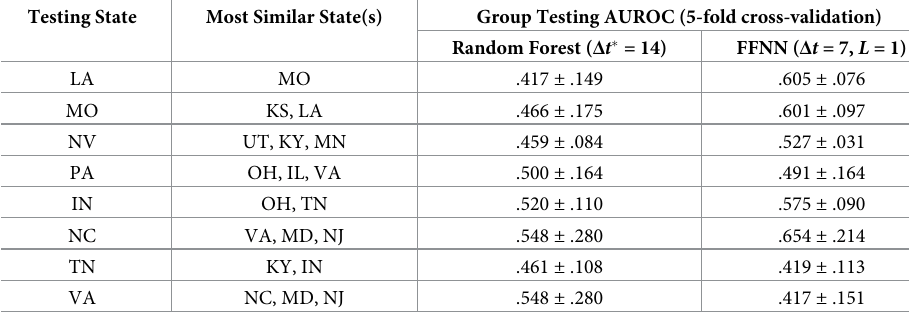
Table 4. Results for group testing on states that have experienced 5–7